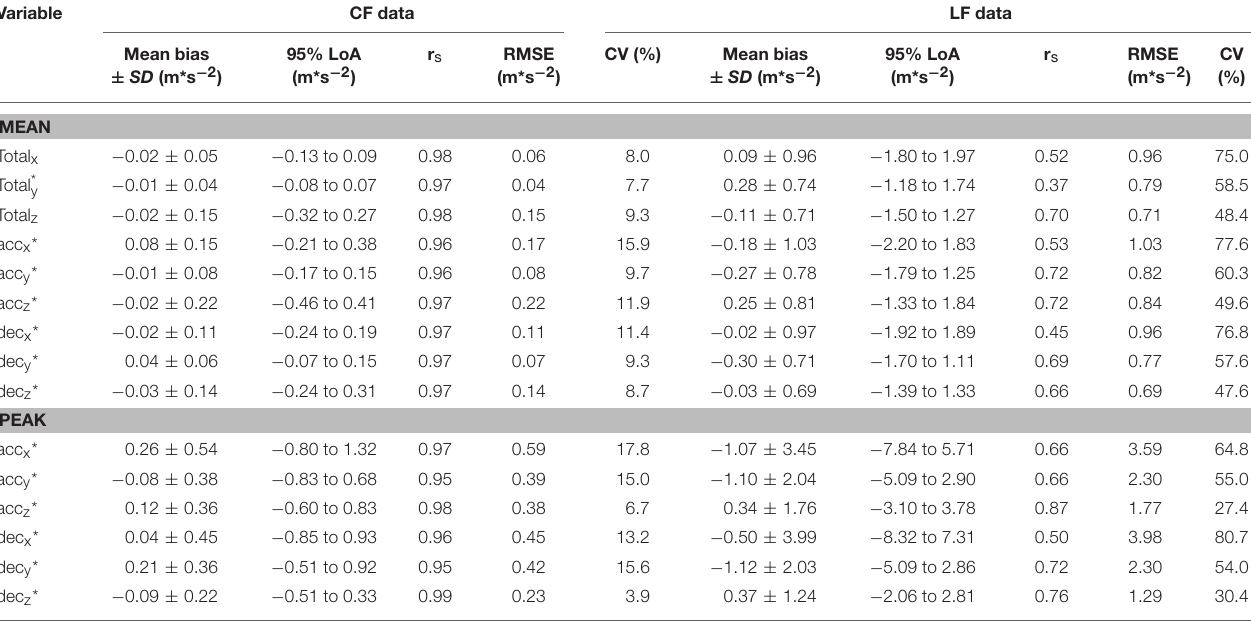
TABLE 2 | Analysis of agreement between CF data respective LF data and MA system data. Variable